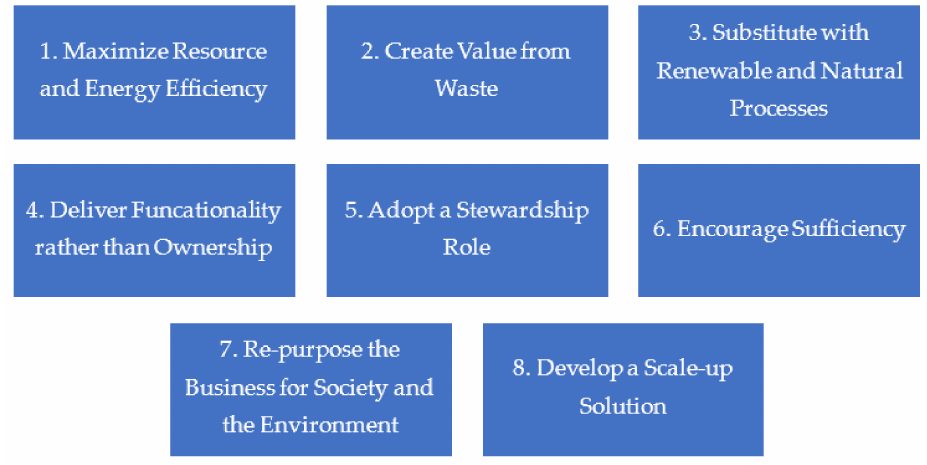
Figure 2. Categorization of sustainable business archetypes. Adopted from